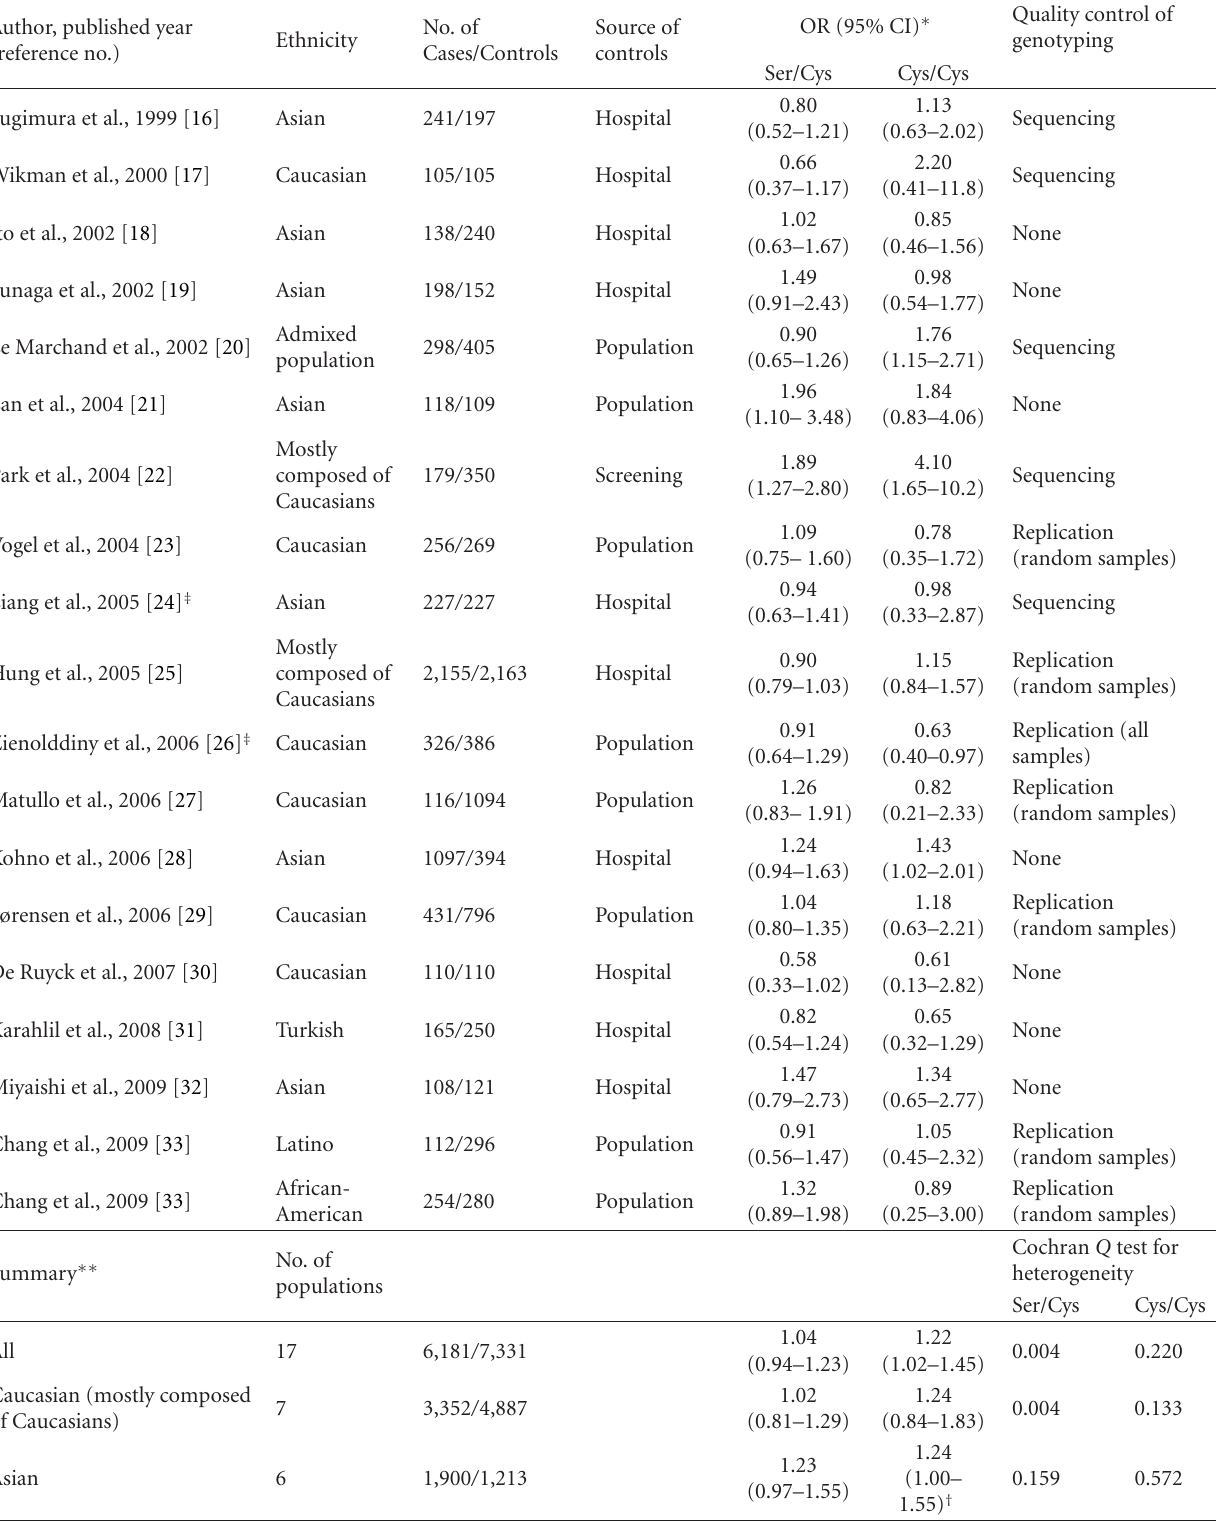
Table 2: Genetic polymorphisms in the BER pathway and lung cancer risk: OGG1 Ser326Cys